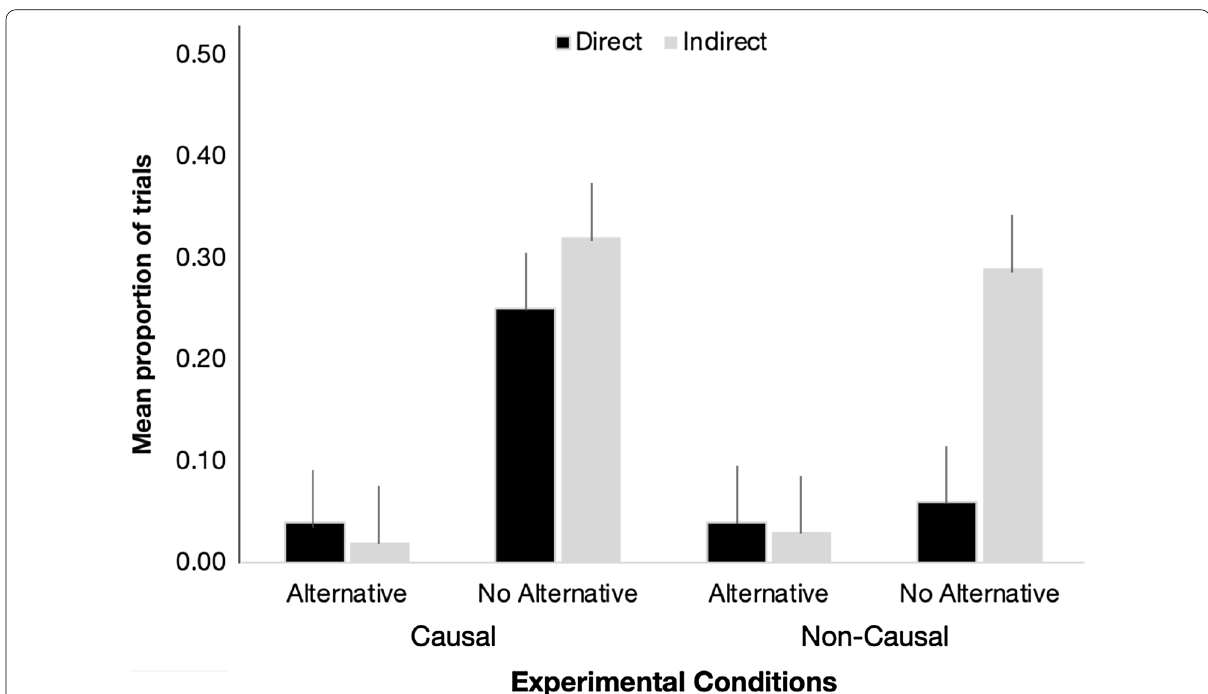
Fig. 7 Mean proportion of trials on which experimental participants endorsed only the misinformation option in Experiment 2. Error bars indicate standard error of the